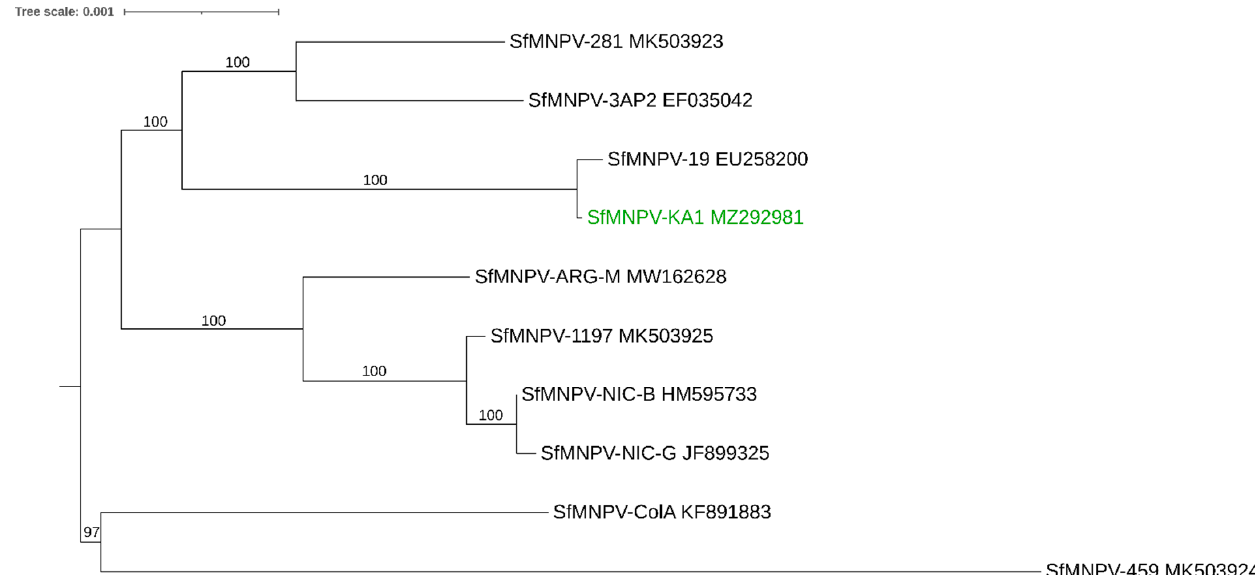
Figure 1. Evolutionary relationship of SfMNPV isolates with completely sequenced genomes. The newly described SfMNPV from Africa (SfMNPV-KA1) [111] is represented in the figure with a green font. The maximum likelihood phylogeny is shown. Numbers indicate maximum likelihood bootstrap values (1000 replicates). The scale bar represents 0.001 expected substitutions per site. Methodology: Whole genome sequences were obtained from GenBank (see accession numbers in the Figure). Both SfMNPV-ColA and SfMNPV-459 contain a region starting near the 3 ′ end of the chitinase gene until the 5 ′ end of the gp37 gene that seems to be acquired by recombination from another alphavirus species (closest match to Spodoptera litura NPVII, EU780426; see Popham et al. [79]. This region was excluded from both isolates (position 21642 until 24292 for SfMNPV-ColA; position 21621 until 24276 for SfMNPV-459). Sequences were aligned using MAFFT version 7 with default settings [147]. PAUP* version 4.0a [148] was used to select the optimal evolution model by critically evaluating the selected parameters [149]. Maximum likelihood analysis (heuristic search, 1000 bootstrap replicates) was performed in PAUP, using a submodel of the General Time Reversible Model with invariable sites and a gamma distribution of among-site rate variation (GTR + I + G) with rate class ‘abcdea’.